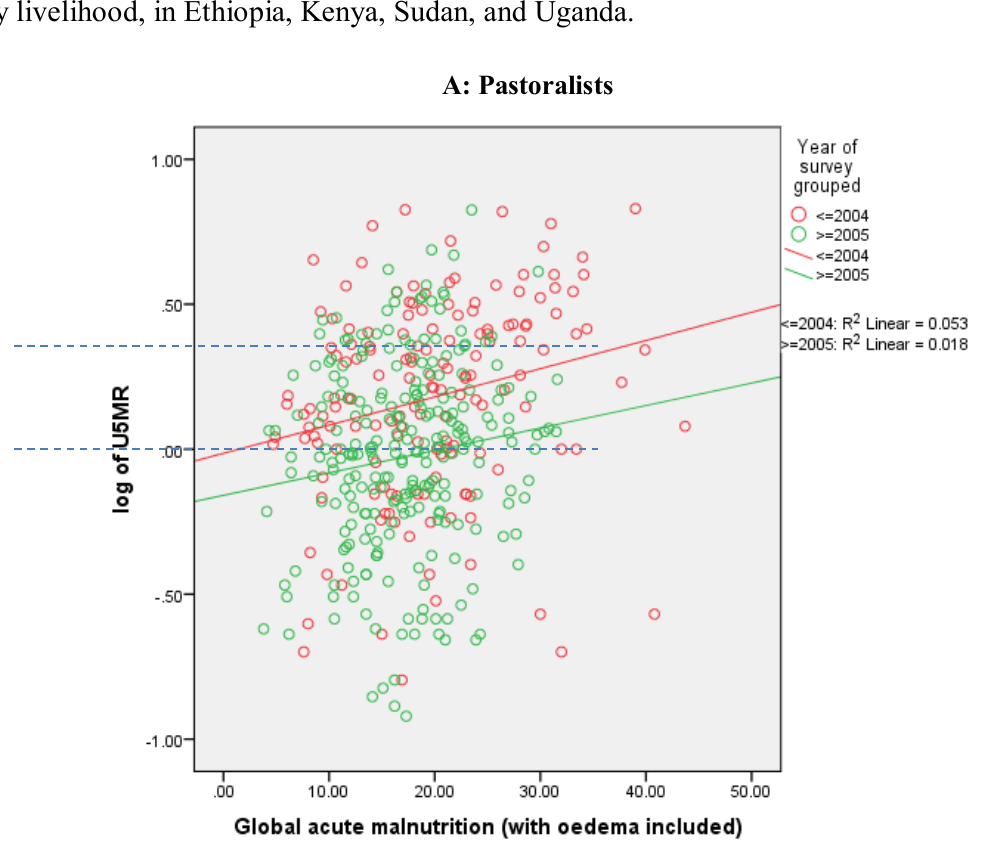
U5MR) with GAM for displaced 10